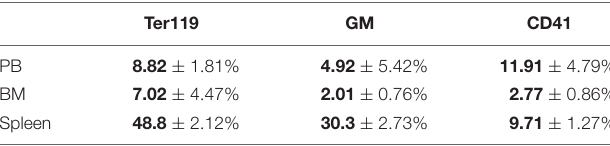
PB, peripheral blood; BM, bone marrow. The values are mean (bold) ±